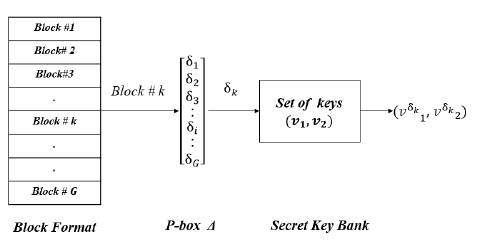
Figure 5: Distribution Test: (a)- Original message, (b)-Enh PORE Cipher 1 (c)-Enh PORE